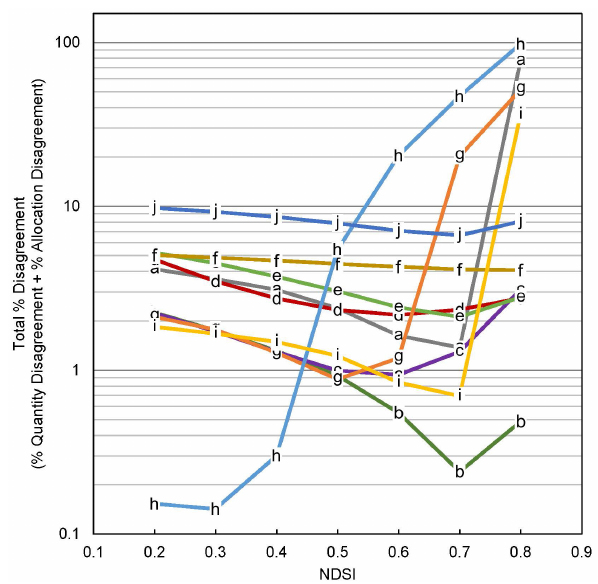
Figure 10. Total quantity and allocation disagreement values (Pon- tius Jr. and Millones, 2011) for pixels extracted from the images in Fig. 8 using the NDSI threshold